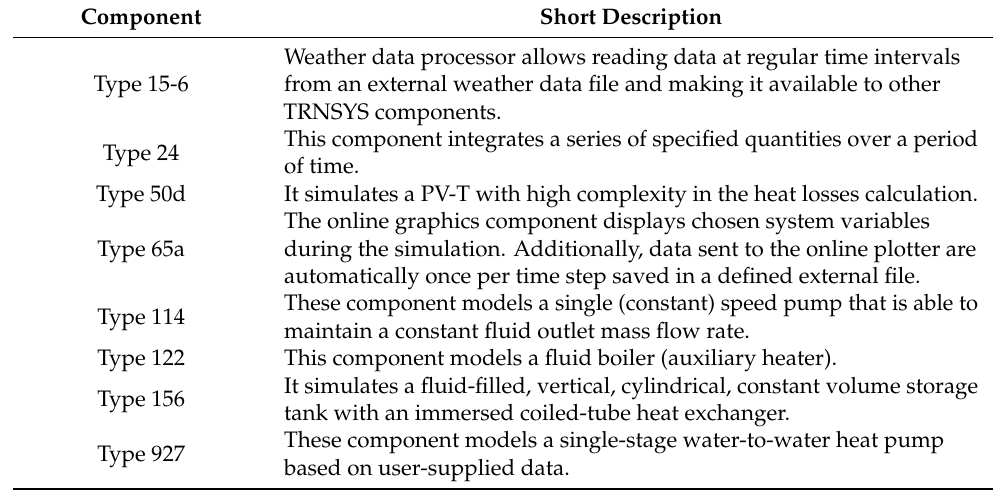
Table A1. Cont. Component